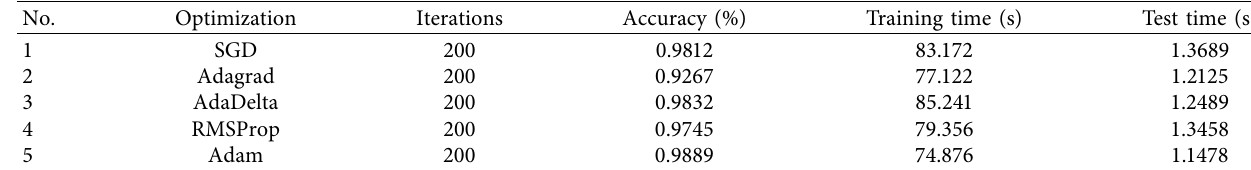
Table 4: The experiment result of different optimization